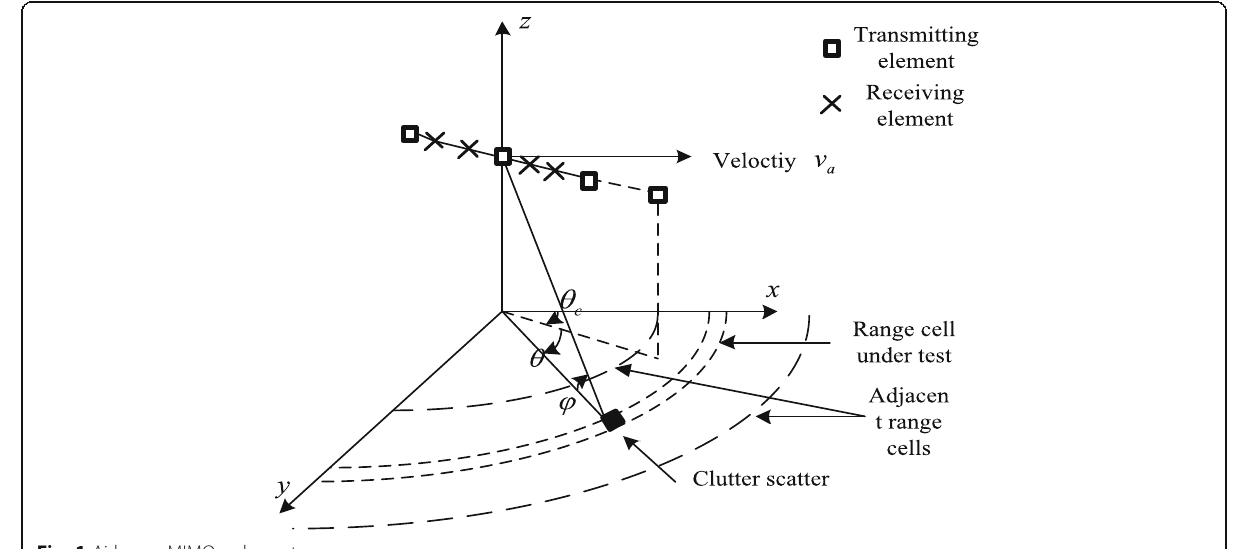
Fig. 1 Airborne MIMO radar